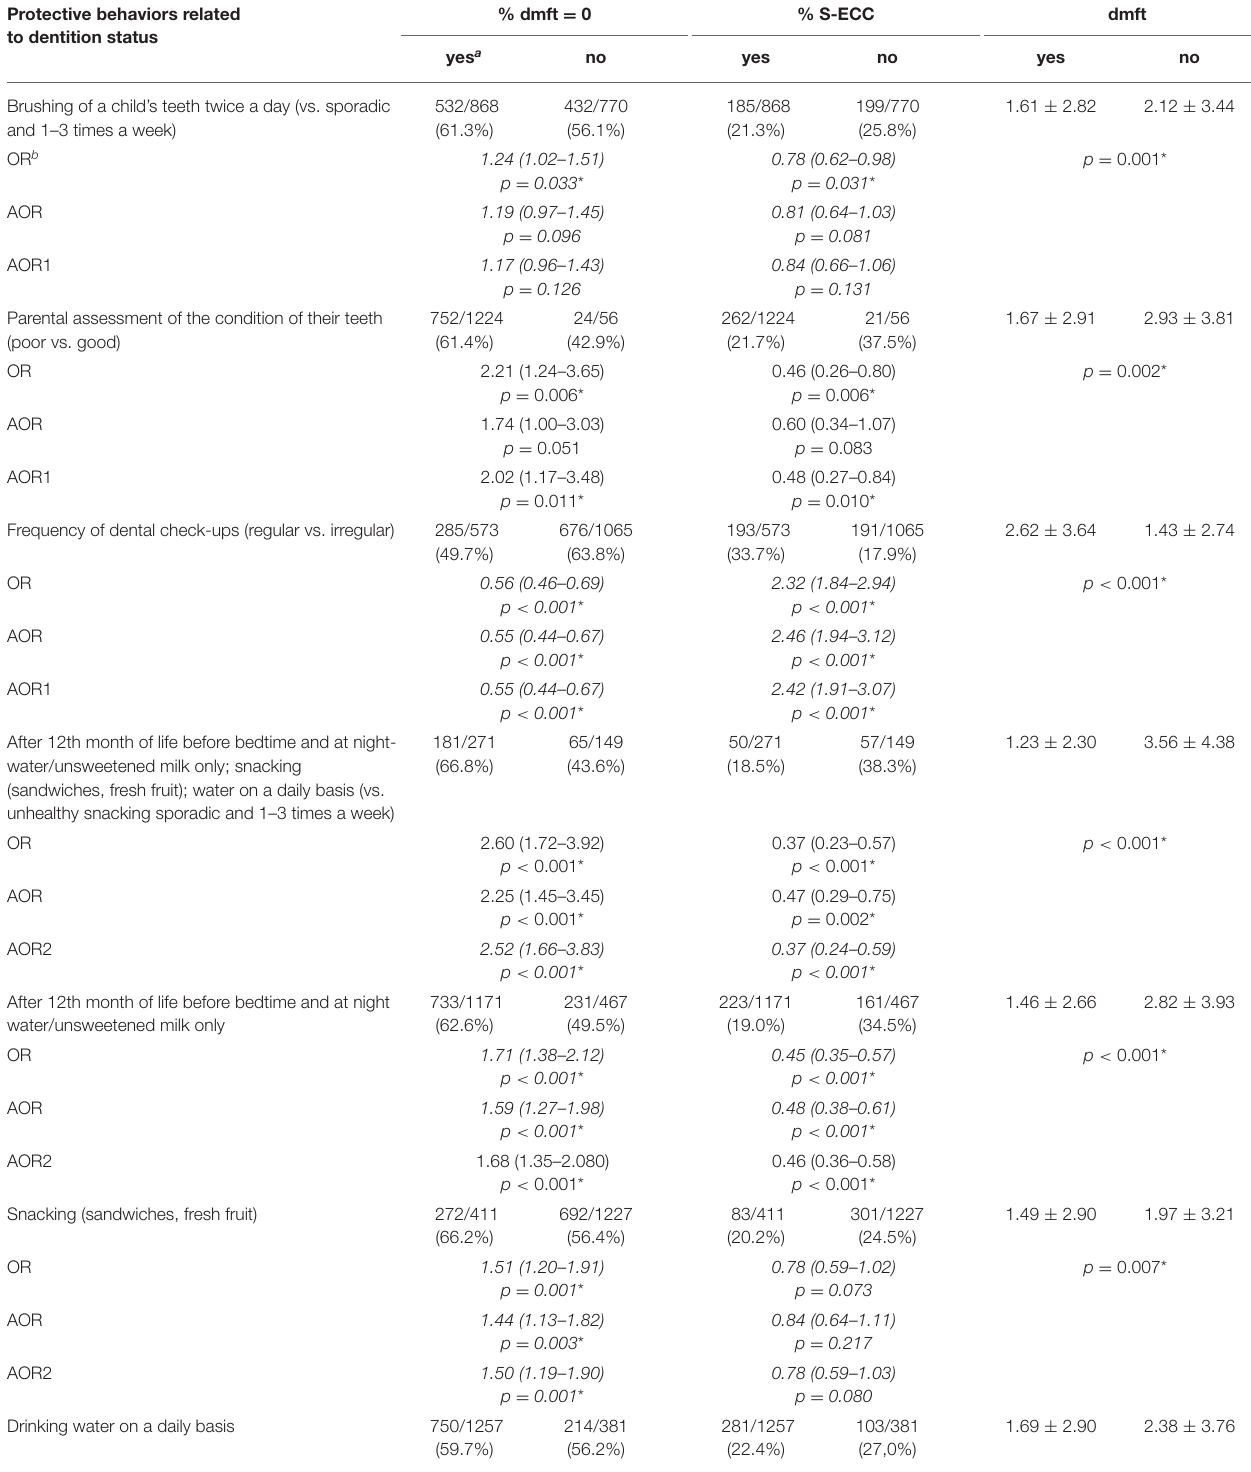
TABLE 2 | Relationship between ECC and behaviors regarded as beneficial for oral health. Protective behaviors related to dentition